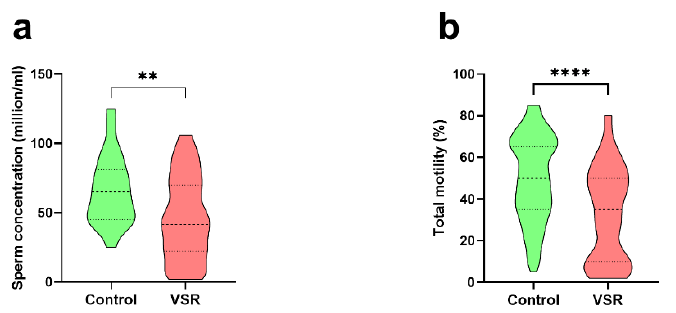
Figure 4. Statistical analysis of sperm concentration ( a ) and total motility ( b ) of the two groups. In green, control group, in red, VSR group. **: p ≤ 0.01; ****: p ≤ 0.00 01.